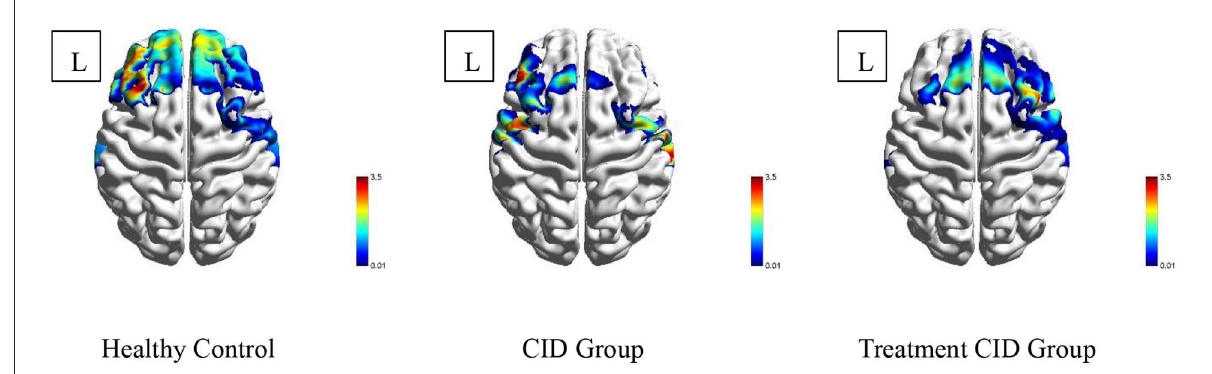
FIGURE2 Activation of the prefrontal lobe of the three subject groups. Different colors in the figure represent the corresponding T -values.